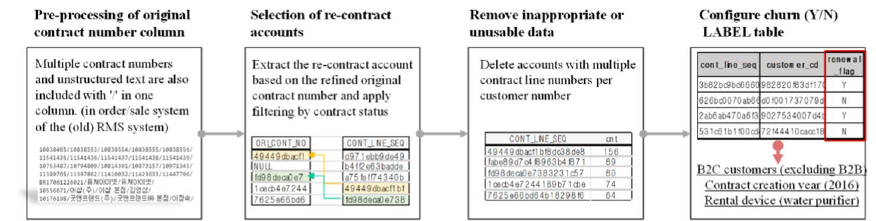
Fig. 1 Detailed logic of creating customer churn (Y/N) LABEL